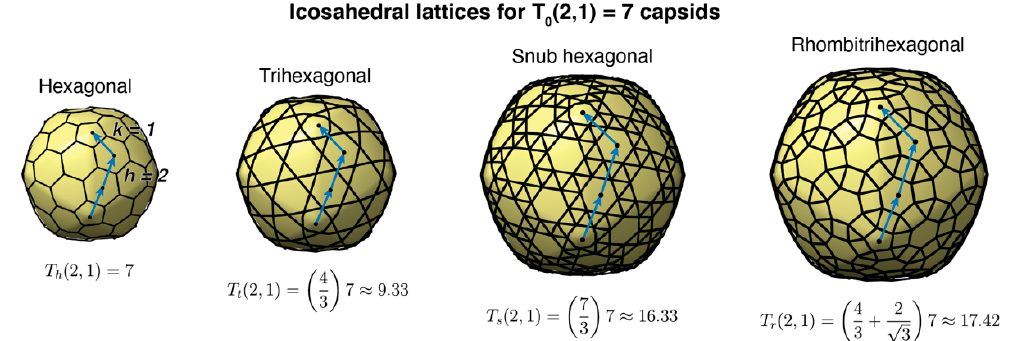
Figure 2. Icosahedral lattices for T(2,1) = 7 capsids. The label on the top displays the name of the lattice. The blue arrows and blue dots display the h and k steps in the hexagonal lattice, h = 2 and k = 1 in this case. The generalized T h , T t , T s , and T r numbers are obtained from the classic T-number multiplied by the lattice factor associated with the minor polygons (triangles and squares) of each lattice: h (hexagonal), t (trihexagonal), s (snub hexagonal), and r (rhombitrihexagonal).